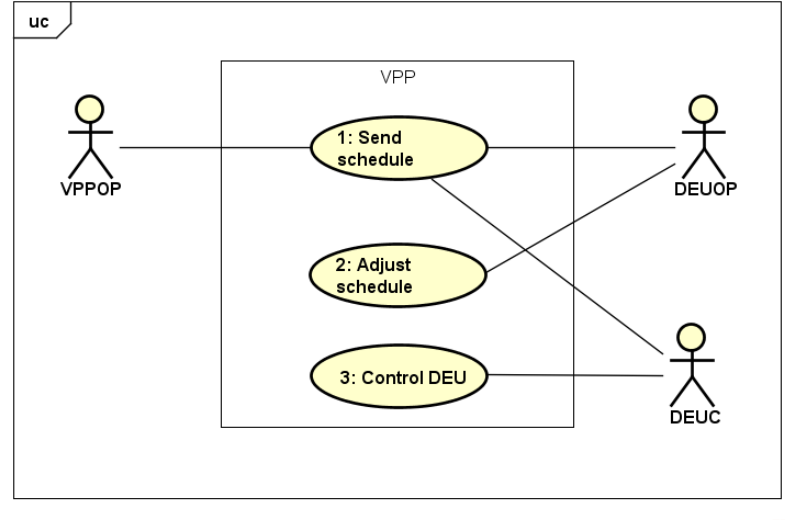
Figure 10. Use Case Diagram: Meta-Actors (here: Virtual Power Plant Operator, Distributed Energy Units Operator, Distributed Energy Unit Controller) connected to Use Case specific